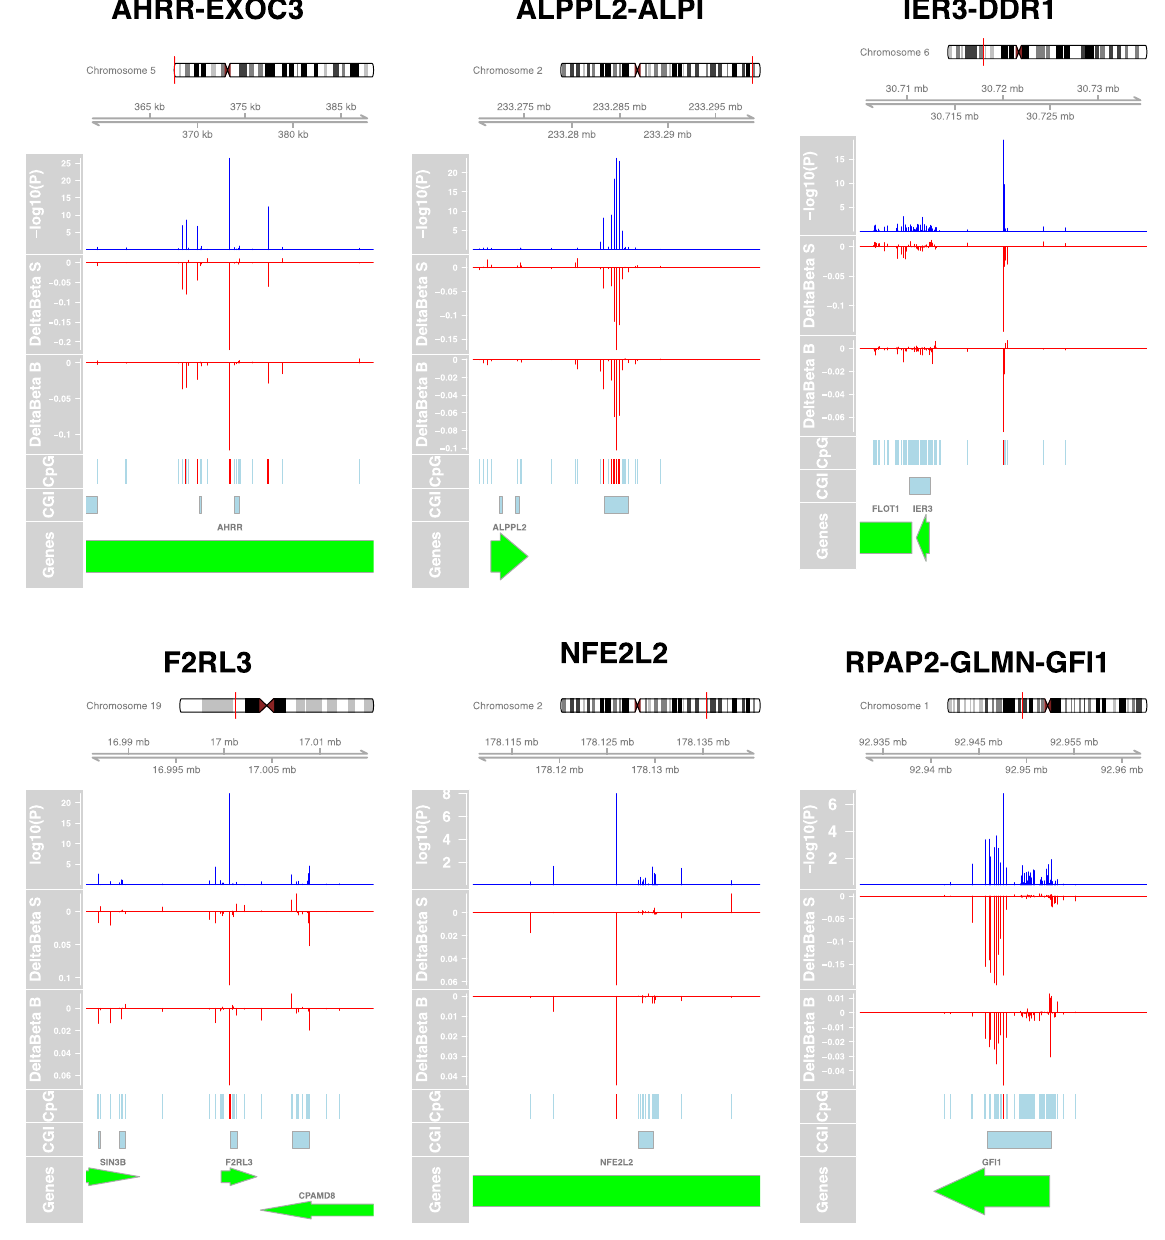
Figure 3. Genomic localization of selected DMPs. For six selected DMPs, the panels show: the meta-analysis P-value, the effect size ( Δβ ) for the S and B cohorts, the location of all 450k probes, the CpG islands and the corresponding genes in the region. The plots are centered on the most significant DMPs and extended ± 15000